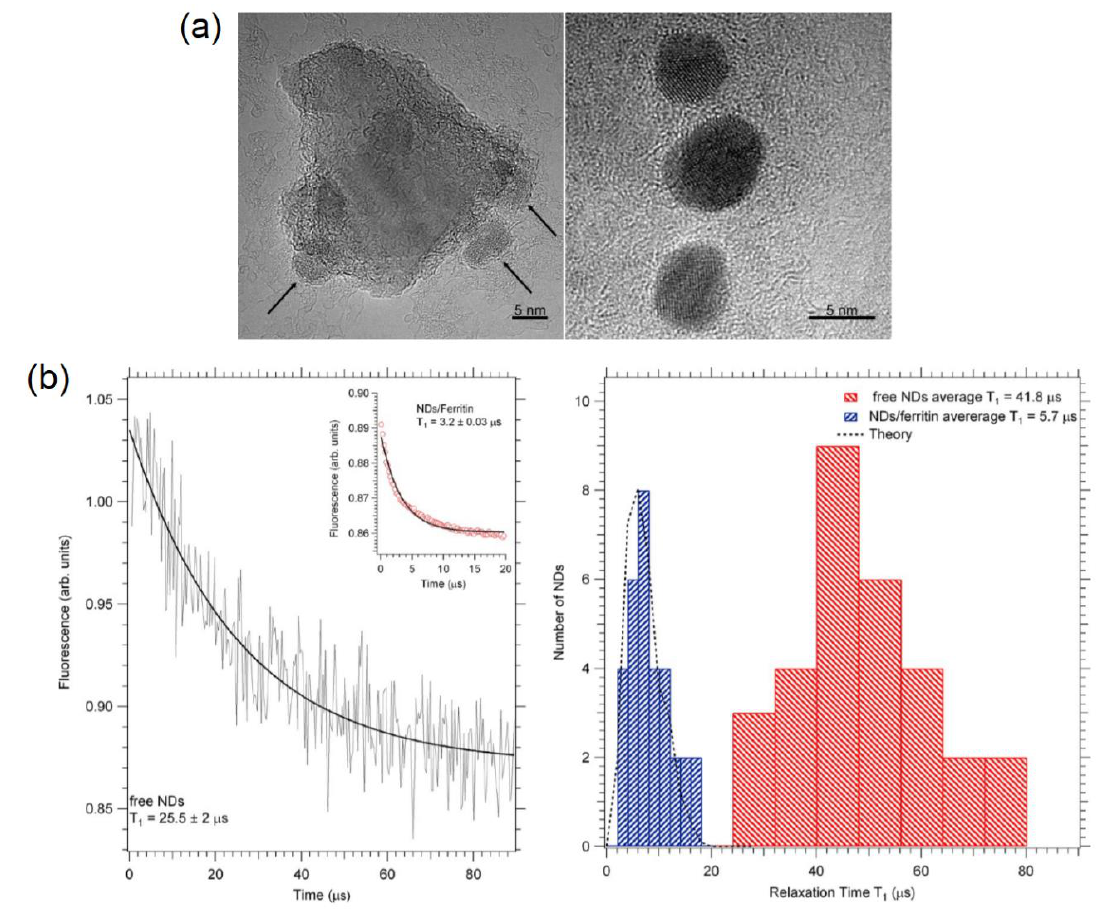
Figure 18. ( a ) High resolution Transmission Electron Microscopy (TEM) of ferritin molecules (right) showing the iron-containing core and a single ND covered with ferritin (left). ( b ) The spin relaxation time T1 of naked NV (left) and in ferritin-coated NDs (left, inset). Statistical distribution of the T1 for bare NDs (right, blue bars) and for ferritin-coated NDs (right, red bars). Reprinted with permission from [111], American Chemical Society, 2013.